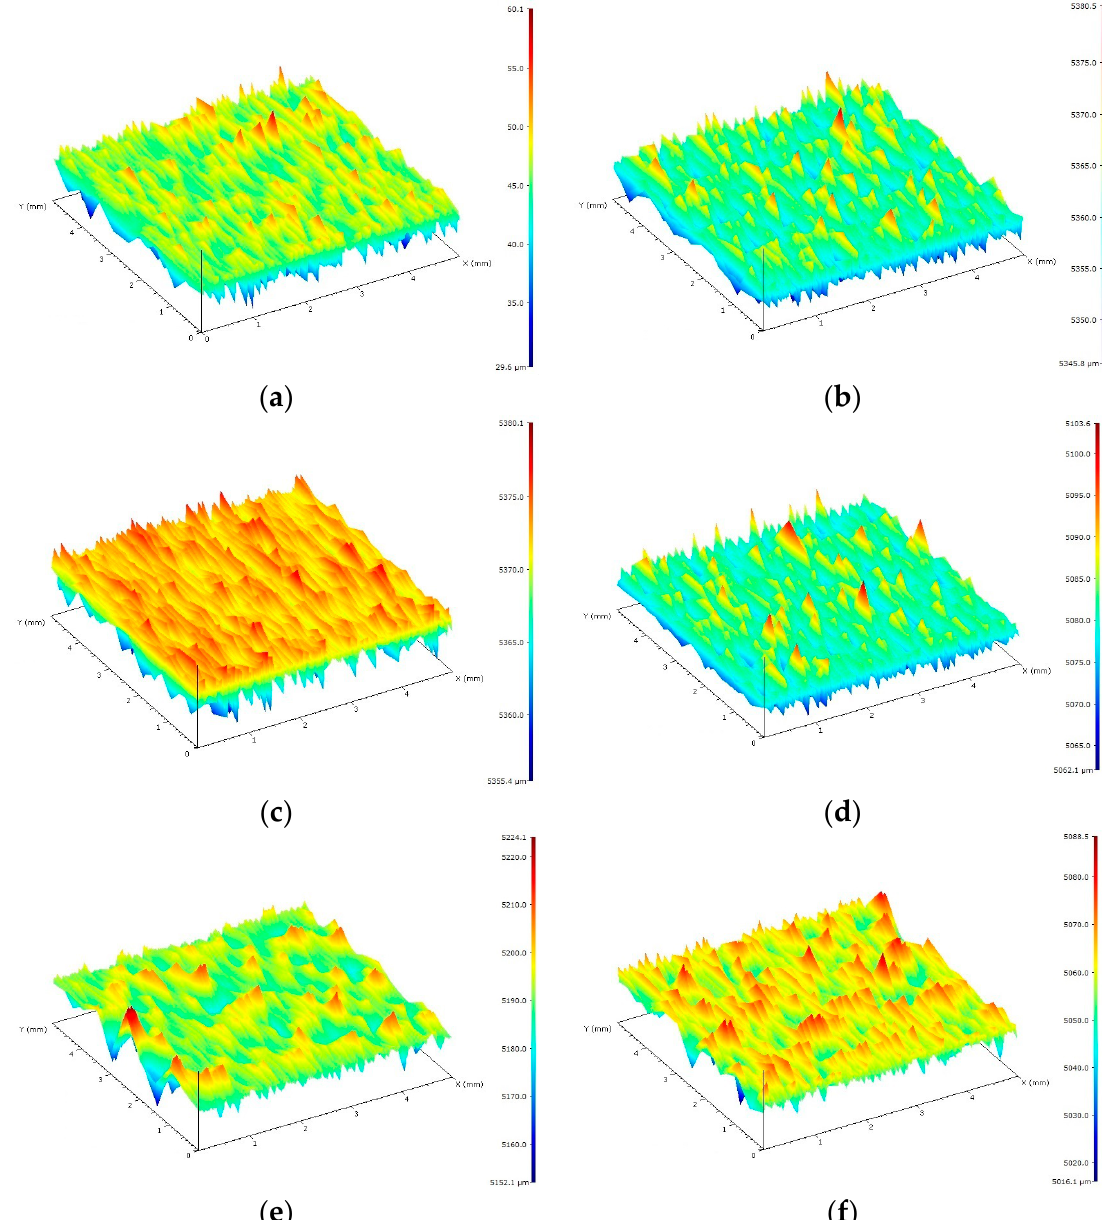
Figure 9. Examples of topography images of the surface area of PP samples after laser marking at velocity B, depending on LMA content and surface type before the marking: ( a ) P surface without LMA; ( b ) P surface with an LMA content of 2.5 wt %; ( c ) O surface without LMA; ( d ) O surface with an LMA content of 2.5 wt %; ( e ) DC surface without LMA; and ( f ) DC surface with an LMA content of 2.5 wt %.